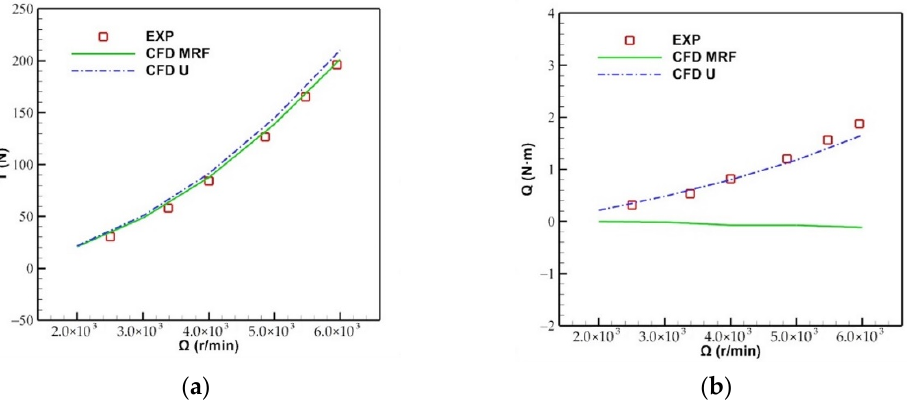
Figure 19. Comparison between the experimental results and CFD results of the 400 ducted fan: ( a )